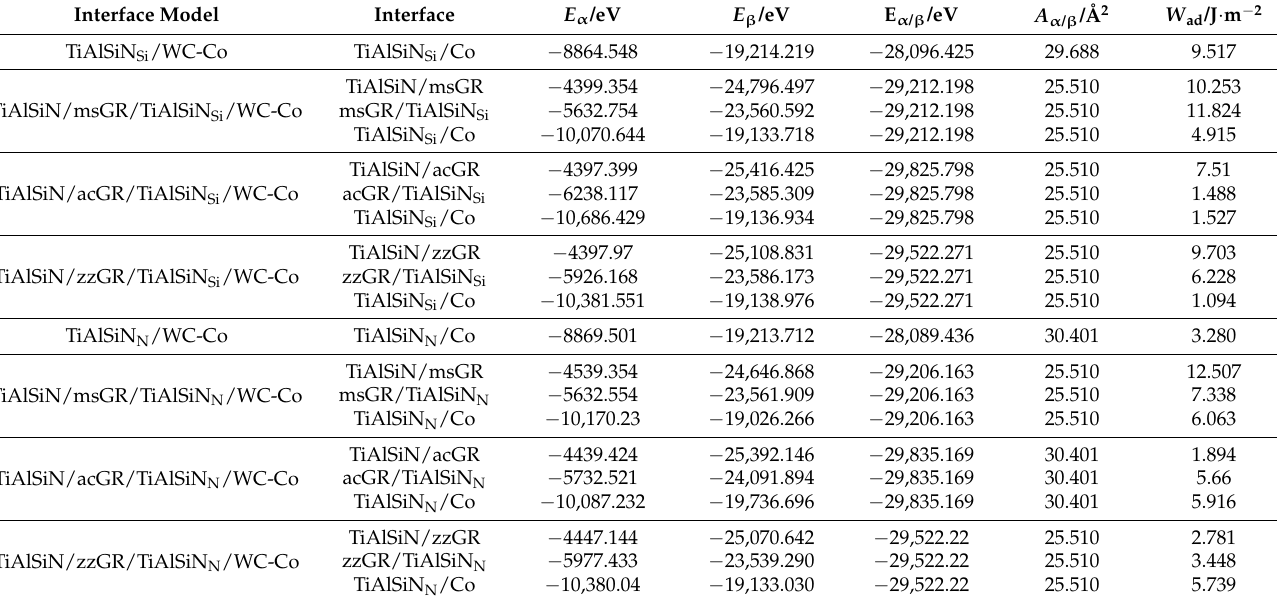
Table 4. Adhesion works of coating doped with intrinsic